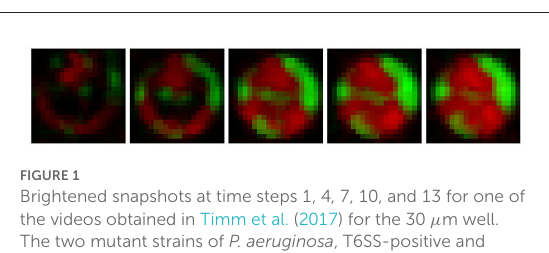
FIGURE1 Brightened snapshots at time steps 1, 4, 7, 10, and 13 for one of the videos obtained in Timm et al. (2017) for the 30 µ m well. The two mutant strains of P. aeruginosa , T6SS-positive and T6SS-negative, appear in green and red, respectively.